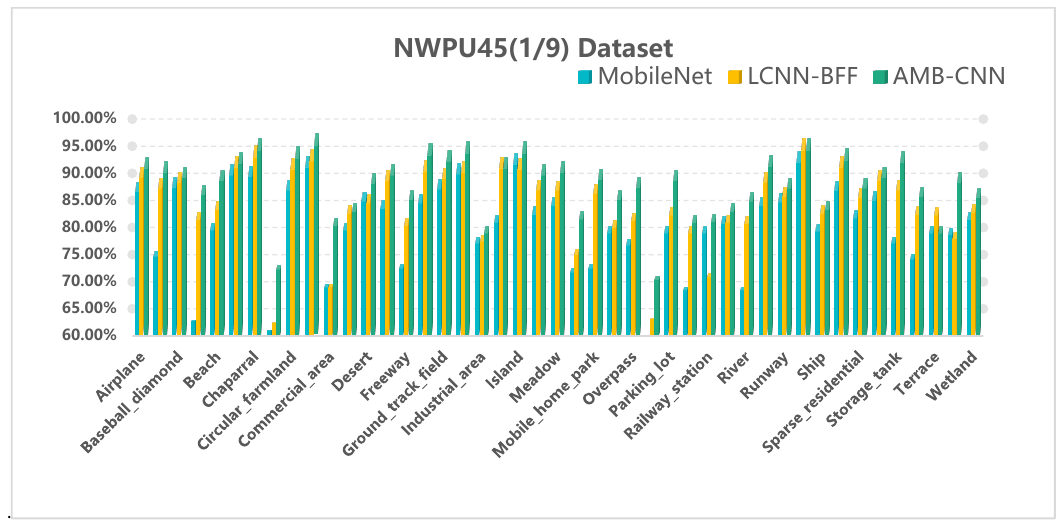
Figure 10. AP comparison results of the three methods for each category of the NWPU45 (1/9) dataset.